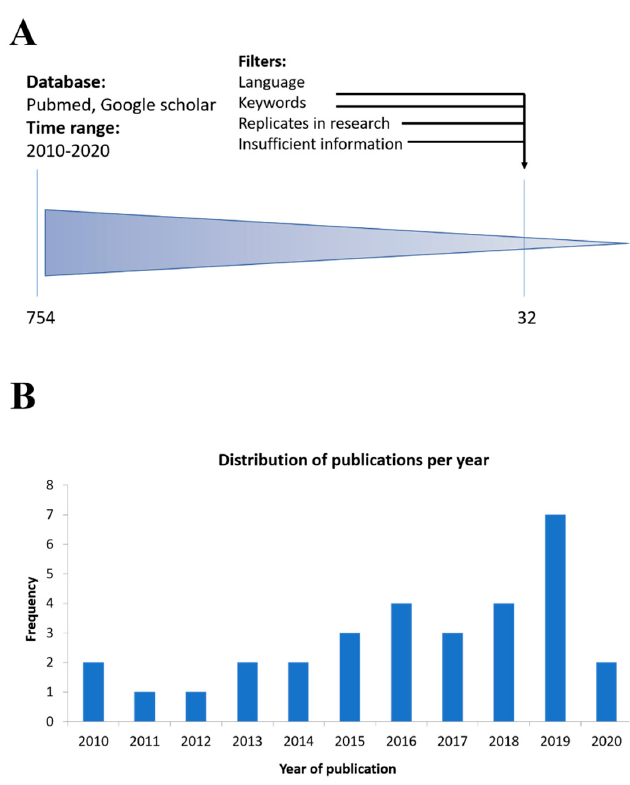
Figure 1. Analysis of nanomaterial-based drug delivery systems in osteoarthritis. ( A ) Procedure used for the literature survey. Studies have been retrieved using the research string “drug delivery AND osteoarthritis AND macrophages OR innate immunity OR inflammation OR immune system OR anti-inflammatory OR nanomaterials OR nanoparticles” on PubMed and Google Scholar, using as a time range the period 2010–2020. With these research criteria, we found 754 studies, and then after excluding the replicates, studies with insufficient information (unclear characteristics of the drug delivery system, missing data about drug dosage or time, uninformative anti-inflammatory readout) and studies not written in English language, we finally selected 32 studies. ( B ) Diagram showing the distribution of the included studies according to the year of publication.